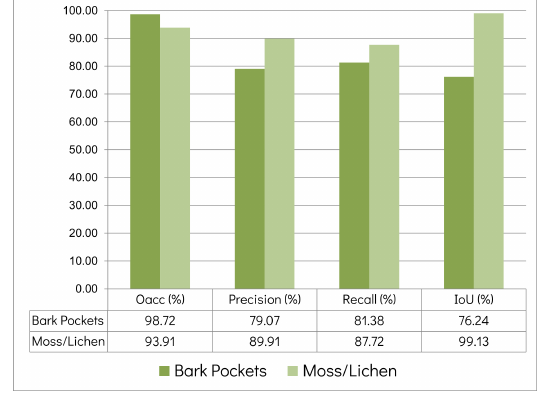
Figure 3. Overview of VR segmentation performance